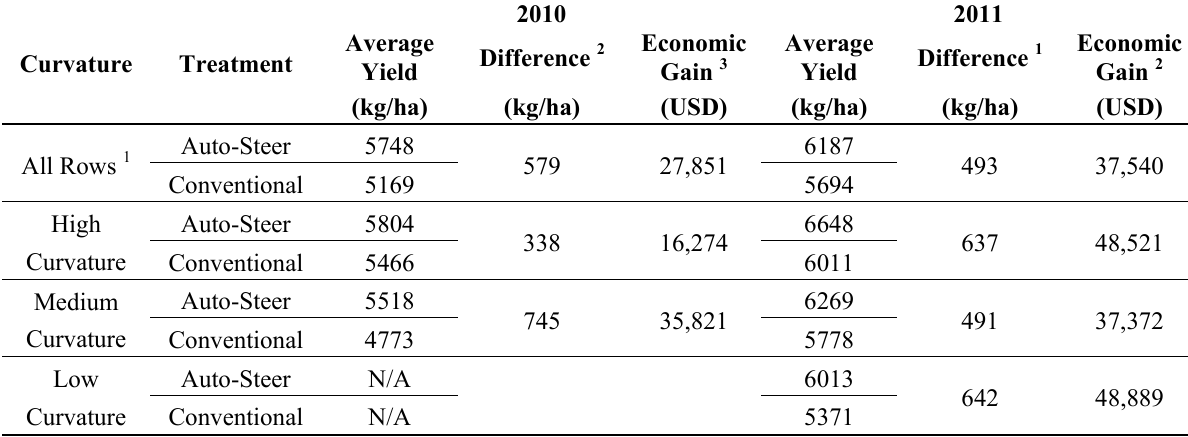
Table 1. Comparison between the effect of conventional and auto-steer on peanut yield during the 2010 and 2011